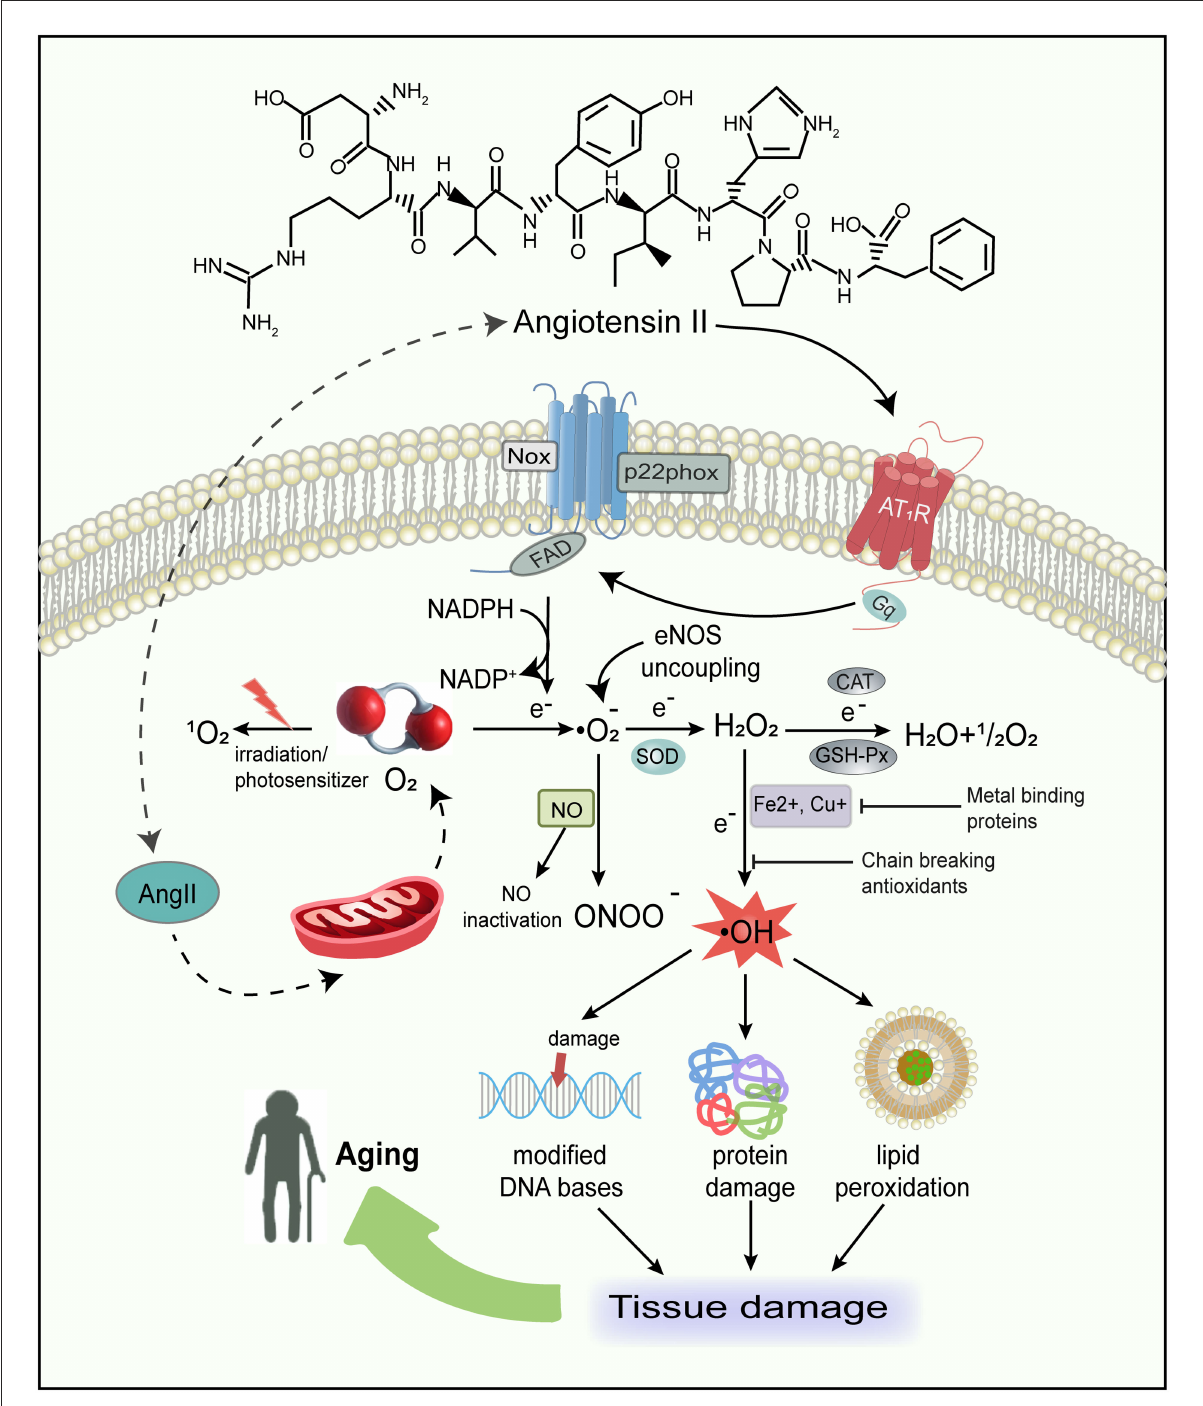
FIGURE2 Schematic representation of major sources of free radicals in the body and the consequences of free radical damage. Ang II not only produces ROS by activating Nox and favoring eNOS uncoupling, but also has a direct action on mtROS production. The oxidative stress in turn can damage macromolecules, such as proteins, lipids, and DNA, therefore resulting in tissue damage and aging. ROS, reactive oxygen species; Nox, NAD(P)H oxidase; eNOS, endothelial NO synthase; mtROS, mitochondrial reactive oxygen species; O 2 , oxygen; 1 O 2 , singlet oxygen; O • – 2 , superoxide; SOD, superoxide dismutase; H 2 O 2 , hydrogen peroxide; H 2 O, water; OH · , hydroxyl radical; NO, nitric oxide; ONOO-, peroxynitrite; CAT, catalase; GSH-Px, glutathione peroxidase; NADPH, nicotinamide adenine dinucleotide